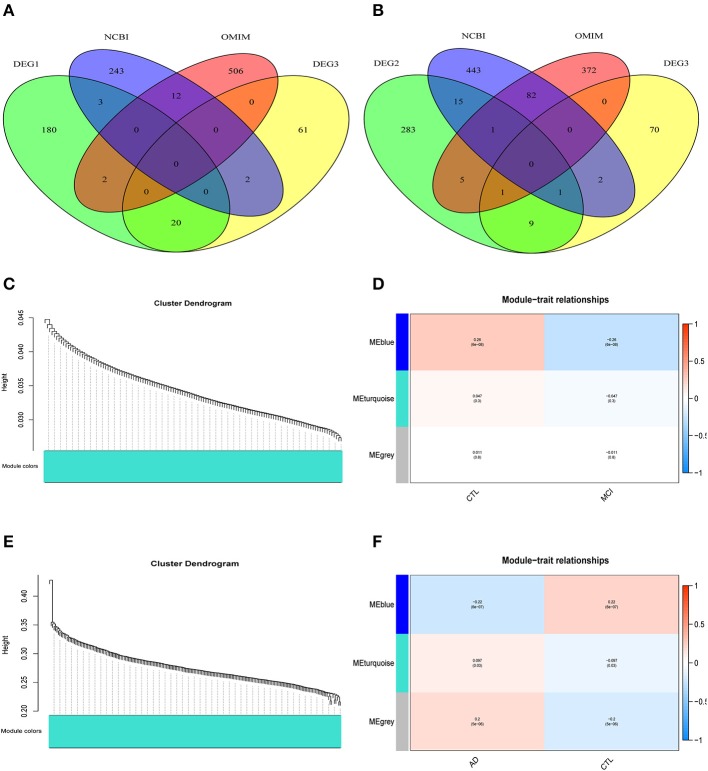
WGCNA co-expression network construction. (A) A total of 1029 potential MCI genes were obtained and displayed in venn figure. (B) A total of 1284 potential AD genes were obtained and displayed in venn figure. (C) The systematic tree diagram of module clustering for MCI genes. (D) WGCNA modules of MCI: each line corresponds to a gene co-expression network (marked with color). The numbers in the table represent the Pearson correlation coefficient r and the associated p-value in parentheses. (E) The systematic tree diagram of module clustering for AD genes. (F) WGCNA modules of AD: each line corresponds to a gene co-expression network (marked with color). The numbers in the table represent the Pearson correlation coefficient r and the associated p-value in parentheses.